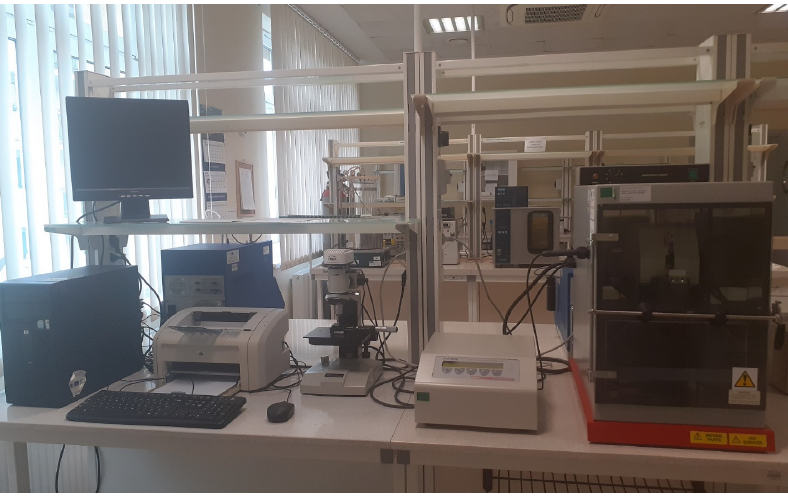
Figure 9. The PCS HFFR V1.0.3 instrument used in the study (photo. M. Szmuka ł